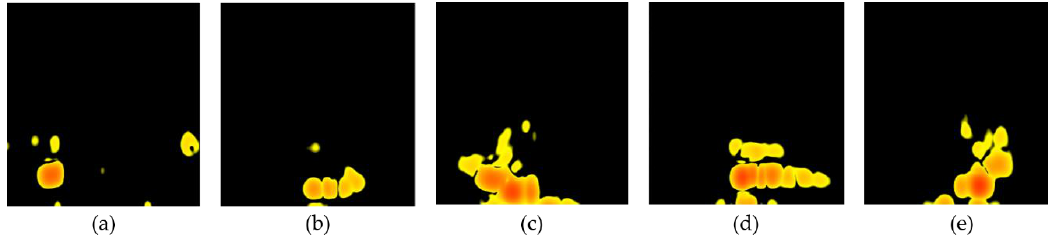
Figure 3. RDM visualization example according to actual hand gestures in a 10 – 15 cm range. Horizontal axis means target radial velocity, vertical axis means range, and color represents decibels relative to full scale (dBFS): ( a ) Swipe; ( b ) Grab; ( c ) Push; ( d ) Clockwise; ( e ) Double-push.